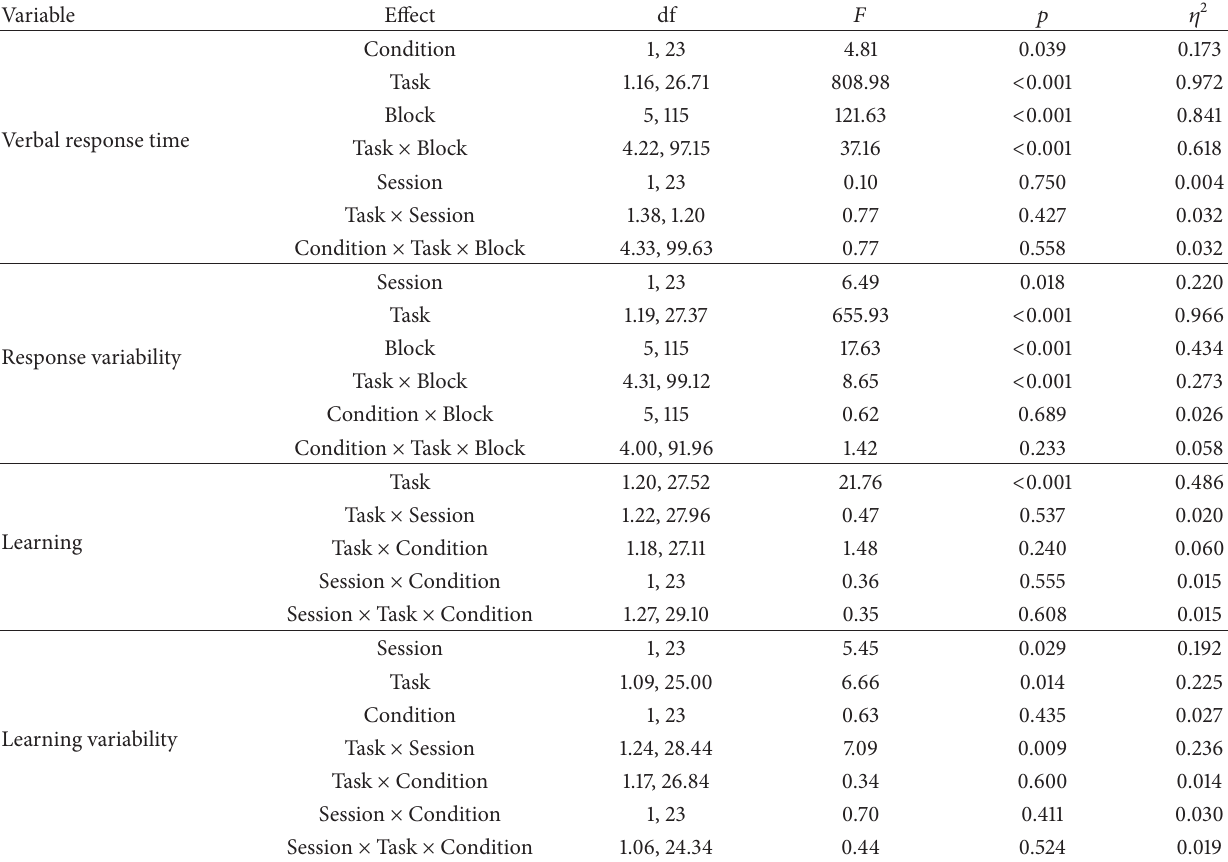
Table 1: Results of the study: verbal response time, response variability, learning, and learning